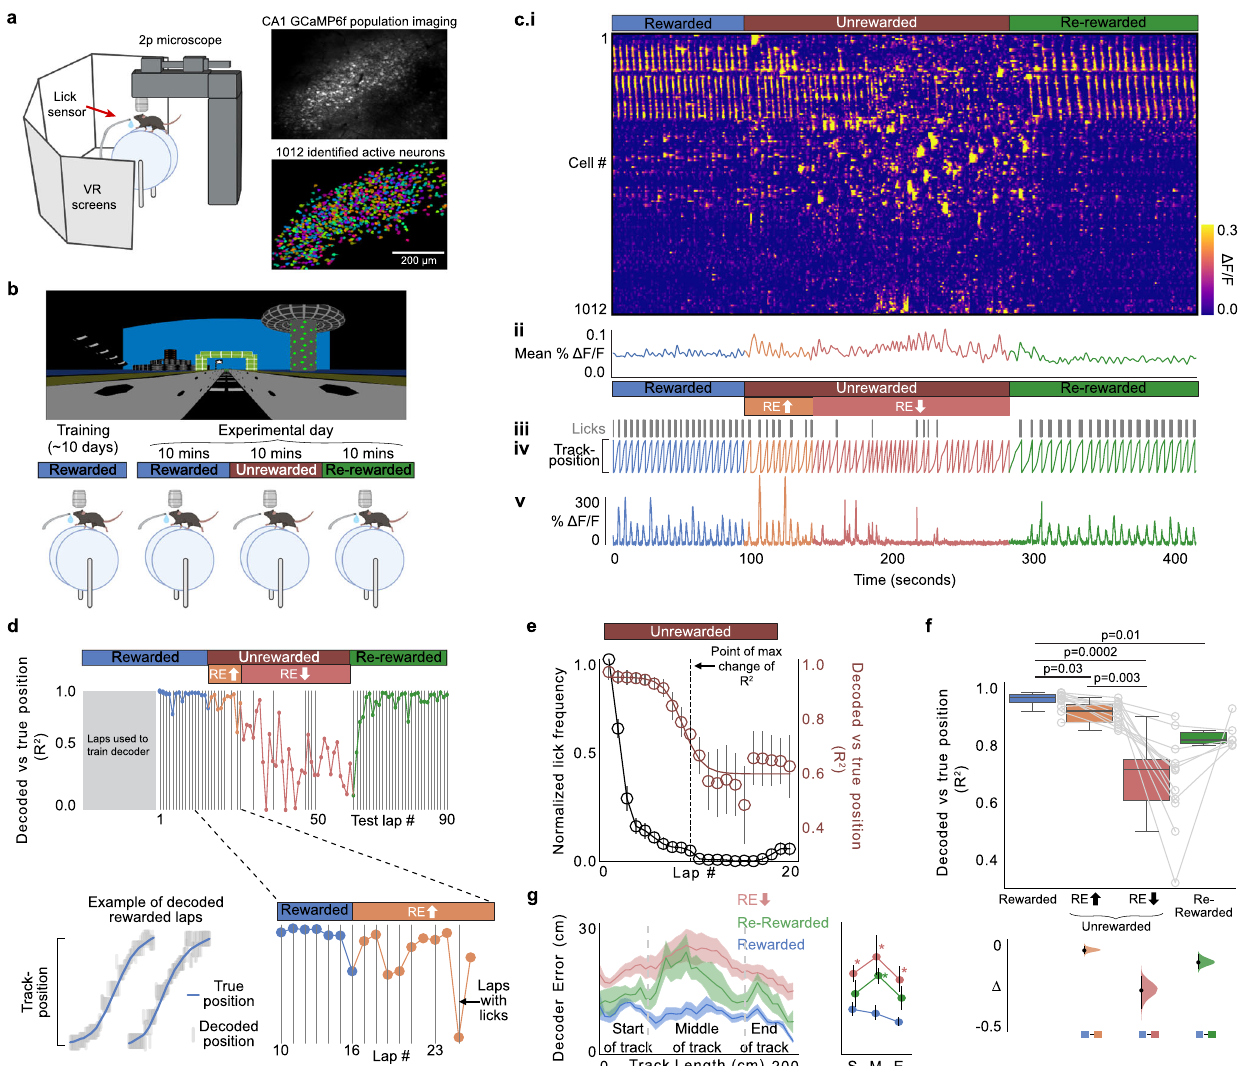
Fig. 1 | Diminished reward expectation restructures spatial encoding in the hippocampus. a Experimental setup (left), created with BioRender.com. A typical fi eld of view in CA1 (right, top). Extracted regions of interest, randomly colored (right, bottom). b Experimental protocol. Image of virtual track (top). Changing reward contingencies (bottom, Rewarded (R), Unrewarded (UR), Re-Rewarded (RR)), created with BioRender.com. c i: Rasterplot representing fl uorescence changes ( Δ F / F ) of cells in A across time. Cells (y-axis) are arranged with the most correlated cells nextto eachother.ii:Mean Δ F / F ofthecellsin(i). iii: Mouselicking behavior.iv:Mousetrackposition.v: Δ F / F fromanexamplecell.Lapsbeforeanimal stopsconsistentlylickinginURwereconsideredlapswithhighrewardexpectation (RE high , orange laps) and after licking stops are laps with low reward expectation (RE low , red laps, see Methods). d A Bayesian decoder was trained on CA1 activity from initial laps in R and tested on remaining laps. (Top) Coef fi cient of determi- nation ( R 2 ) between true and predicted position of tested laps, (bottom right) zoomedin. (Bottom left) Anexample fi t. Gray lines indicate laps with licks. a – d are